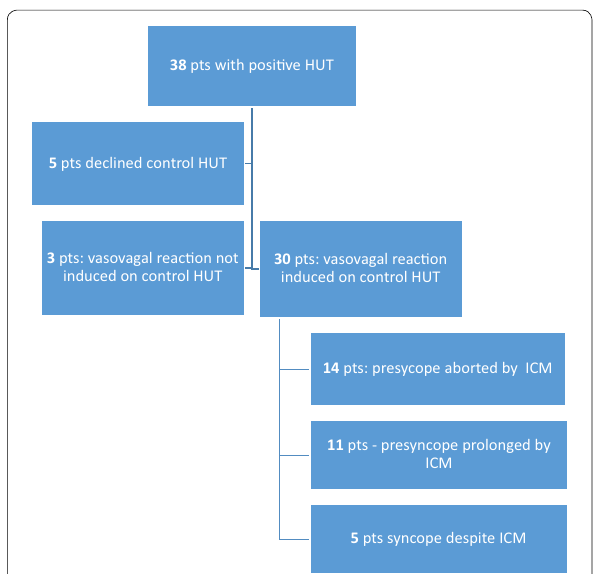
Fig. 4 ICM efficacy during HUT. HUT head-up tilt test, ICM isometric counter maneuver